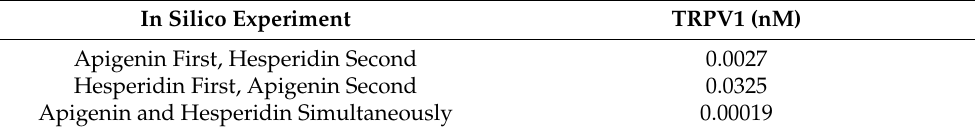
Table 3. TRPV1 estimations for additive effects of apigenin and hesperidin.